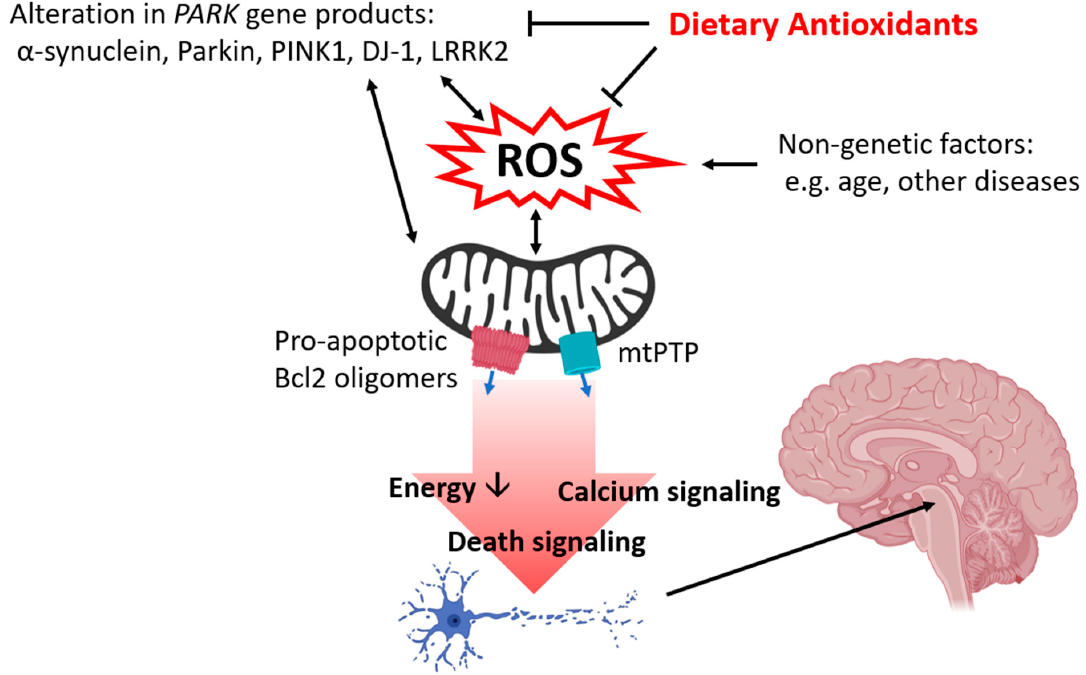
Figure 1. Summary of the protective roles of dietary antioxidants in Parkinson’s disease (PD). Both genetic and nongenetic factors contribute to the accumulation of oxidative stress by enhancing ROS production and impairing cellular antioxidant defense systems. Oxidative stress damages intracellular organelles, most notably the mitochondria, impairing neuronal energy metabolism and thus hindering the energy-demanding process in the brain including neurotransmission and neuritogenesis. Mitochondrial dysfunction primes apoptosis, calcium release, and opening of mtPTP which leads to the death of neurons, including the specific dopaminergic population of the SNpc which produces the signs and symptoms of PD. Illustration by BioRender.